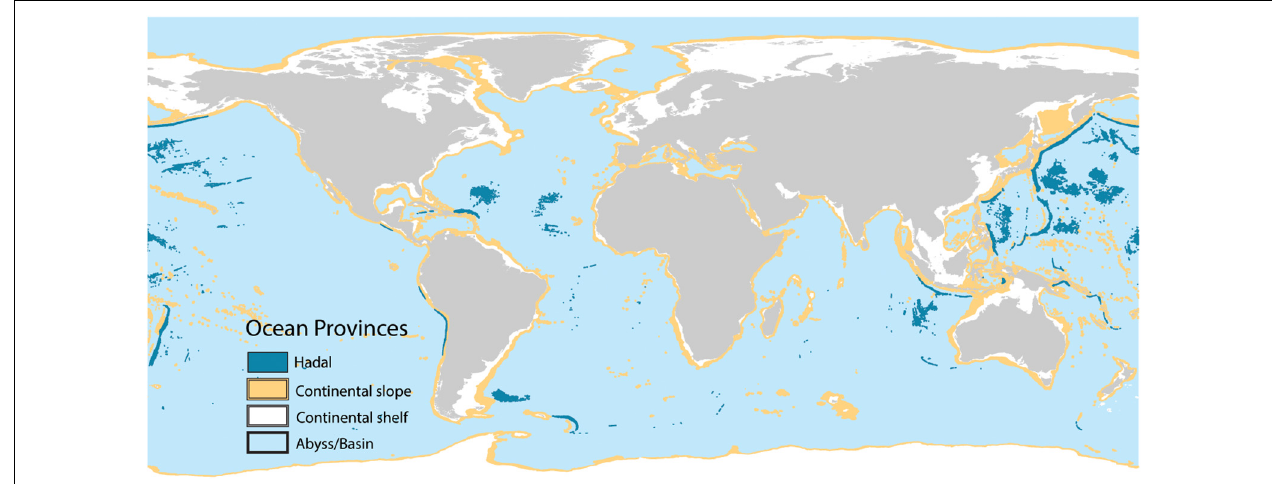
FIGURE 4 | Global distribution of ocean provinces. Data from Harris and Whiteway